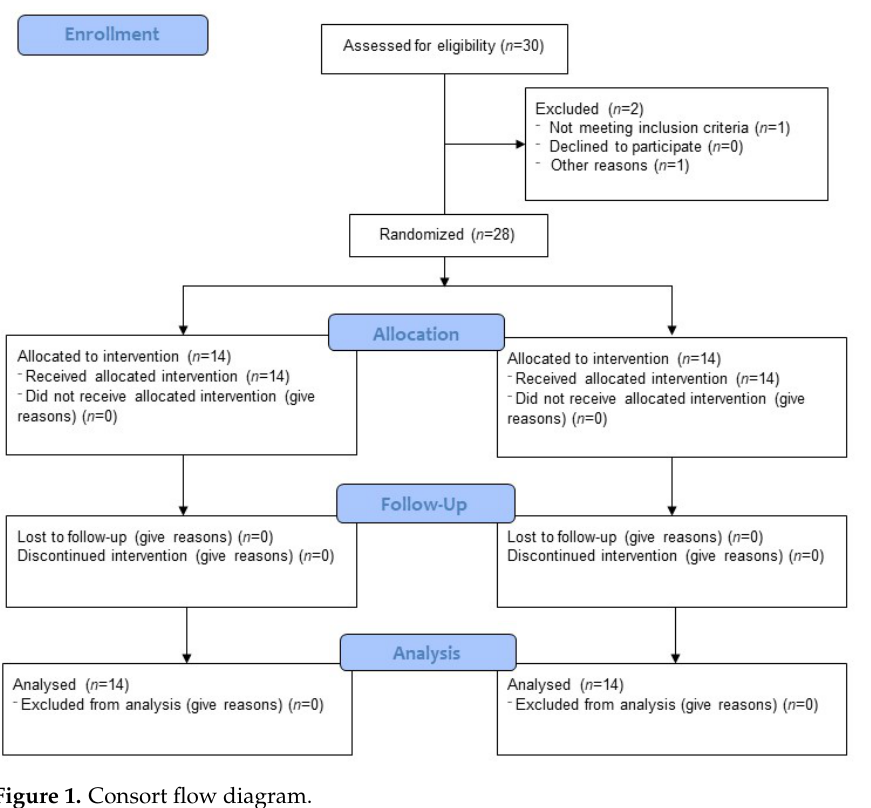
Figure 1. Consort flow diagram.